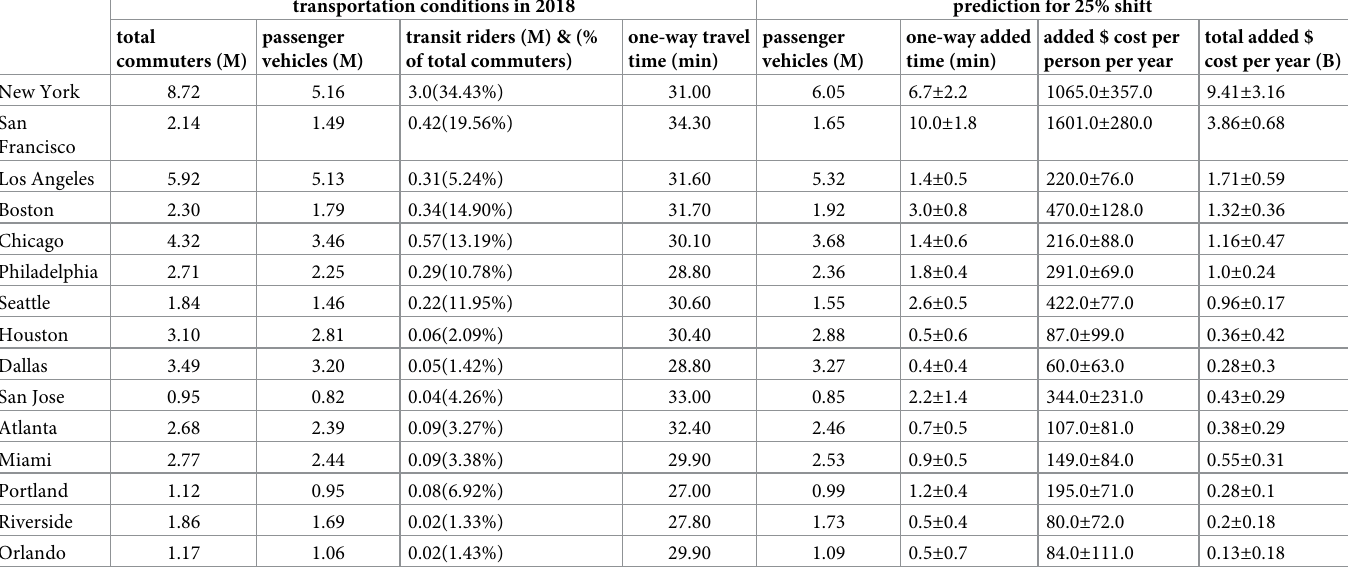
Table 3. Summary of 2018 transportation conditions for 15 metro areas, and changes when 25% of transit riders and carpools switch to single occupancy vehicles. The range shows one standard deviation of the predictions. M denotes millions, and B denotes billions. See S3 Table for all 74 modeled metro areas. transportation conditions in